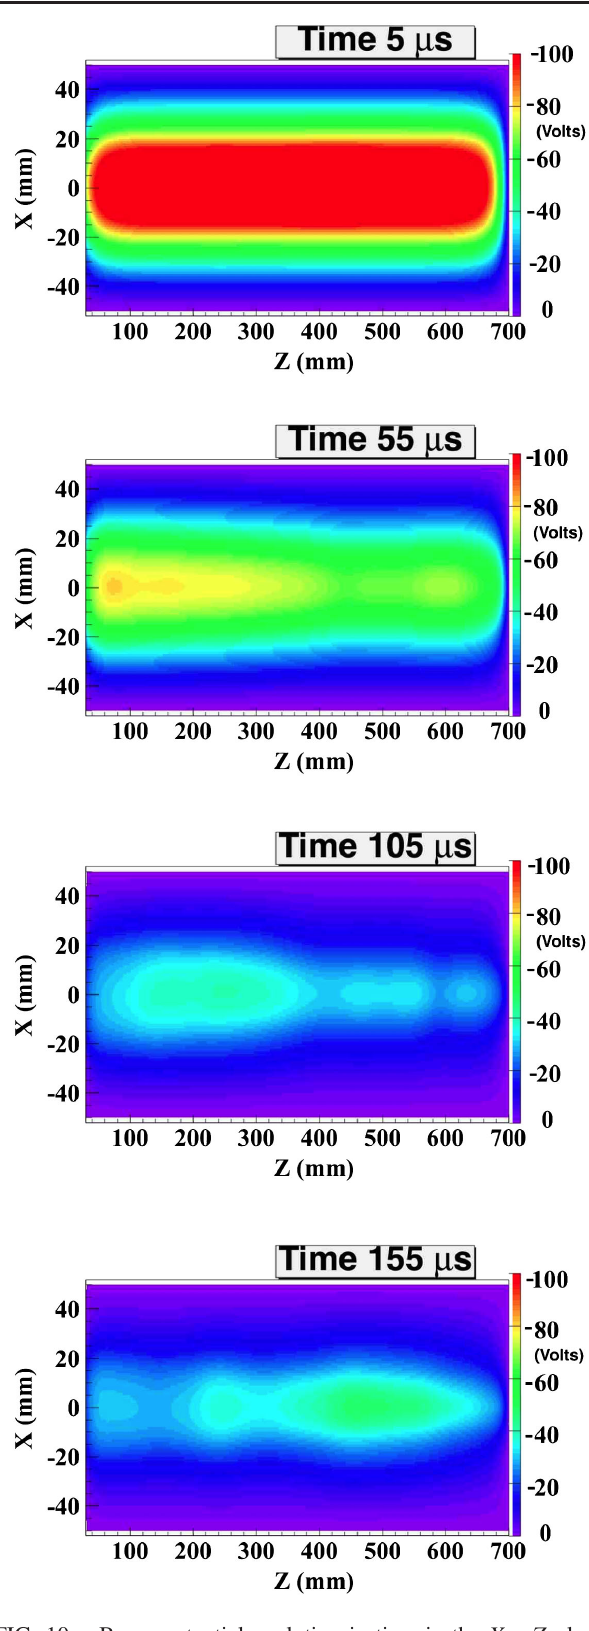
FIG. 10. Beam potential evolution in time in the X − Z plane under the effect of SCC at 2 . 0 × 10 − 6